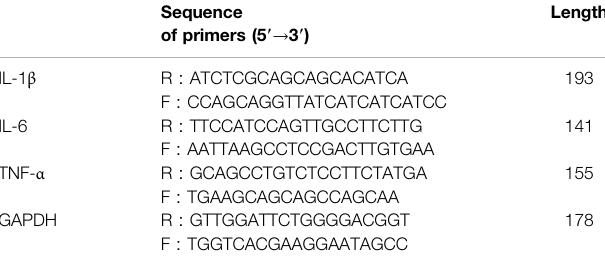
TABLE 1 | Primers used for real-time PCR in this